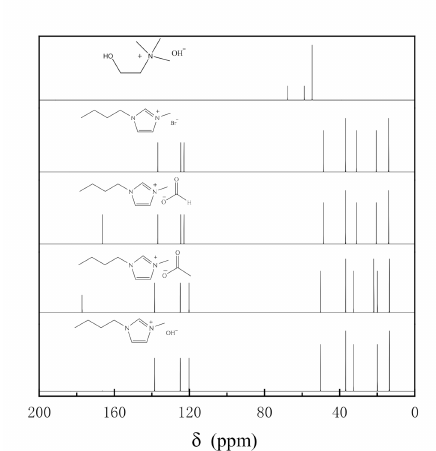
Figure 1. 13 C-NMR spectra of [Bmim]OH, [Bmim][CH 3 COO], [Bmim][HCOO], [Bmim]Br and